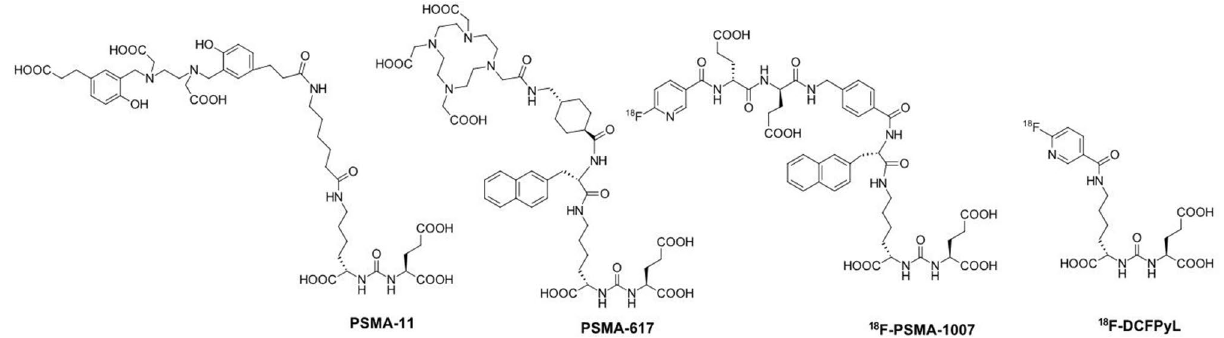
Figure 1. The most often-used precursors based on the Lys-urea-Glu scaffold for PCa